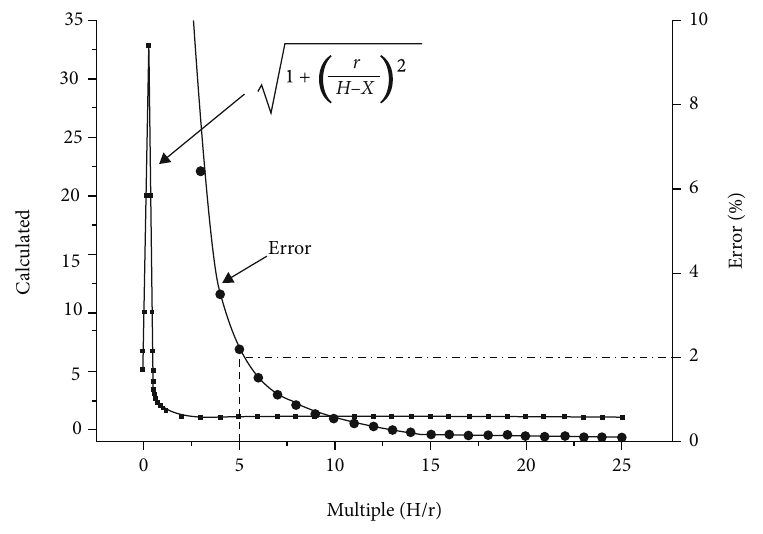
Figure 4: Simplify item error